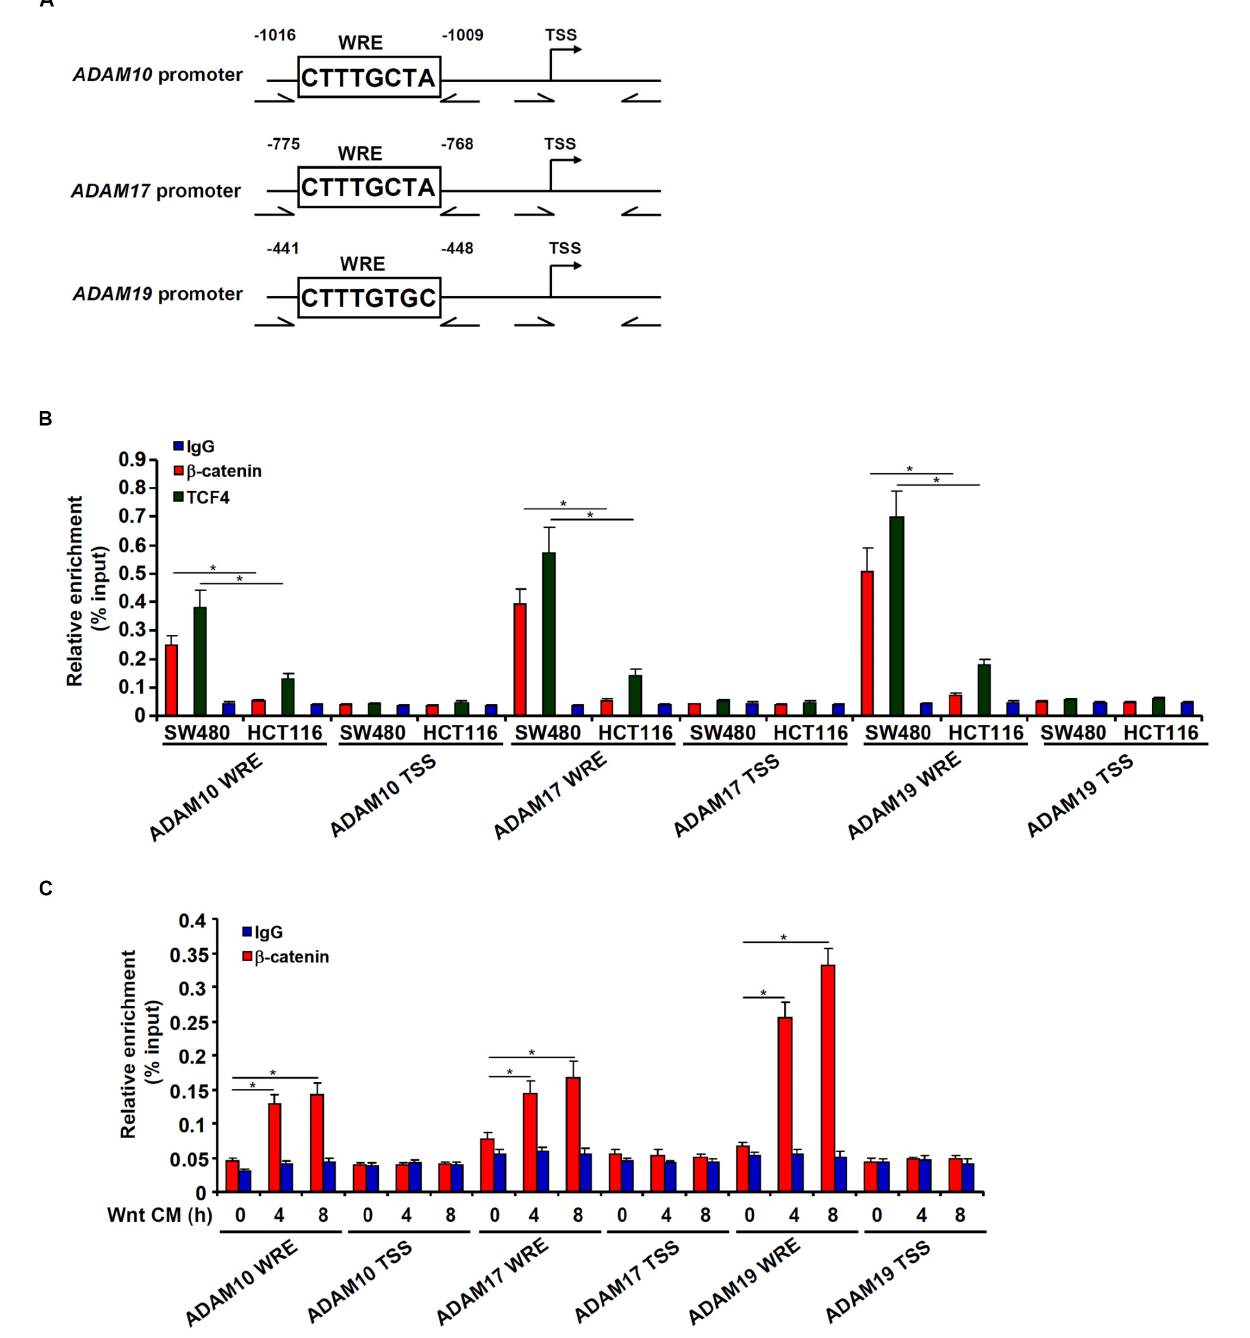
FIGURE 4 | β -catenin directly binds to the ADAM promoters. (A) Schematic structures of the ADAM promoters with the WRE and the ChIP primers highlighted. (B) ChIP assays were performed in SW480 cells and HCT116 cells with anti– β -catenin, anti-TCF4, or IgG. (C) HCT116 cells were treated with Wnt-containing CM and harvested at indicated time points. ChIP assay was performed with anti– β -catenin or IgG. Data represent averages of three independent experiments, and error bars represent SEM ( p < 0.05, two-tailed Student t test).